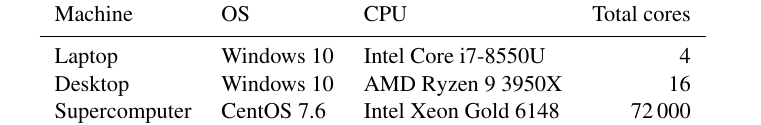
Table 2. The operating system (OS), the central processing unit (CPU), and the total number of cores on the three representative machines.